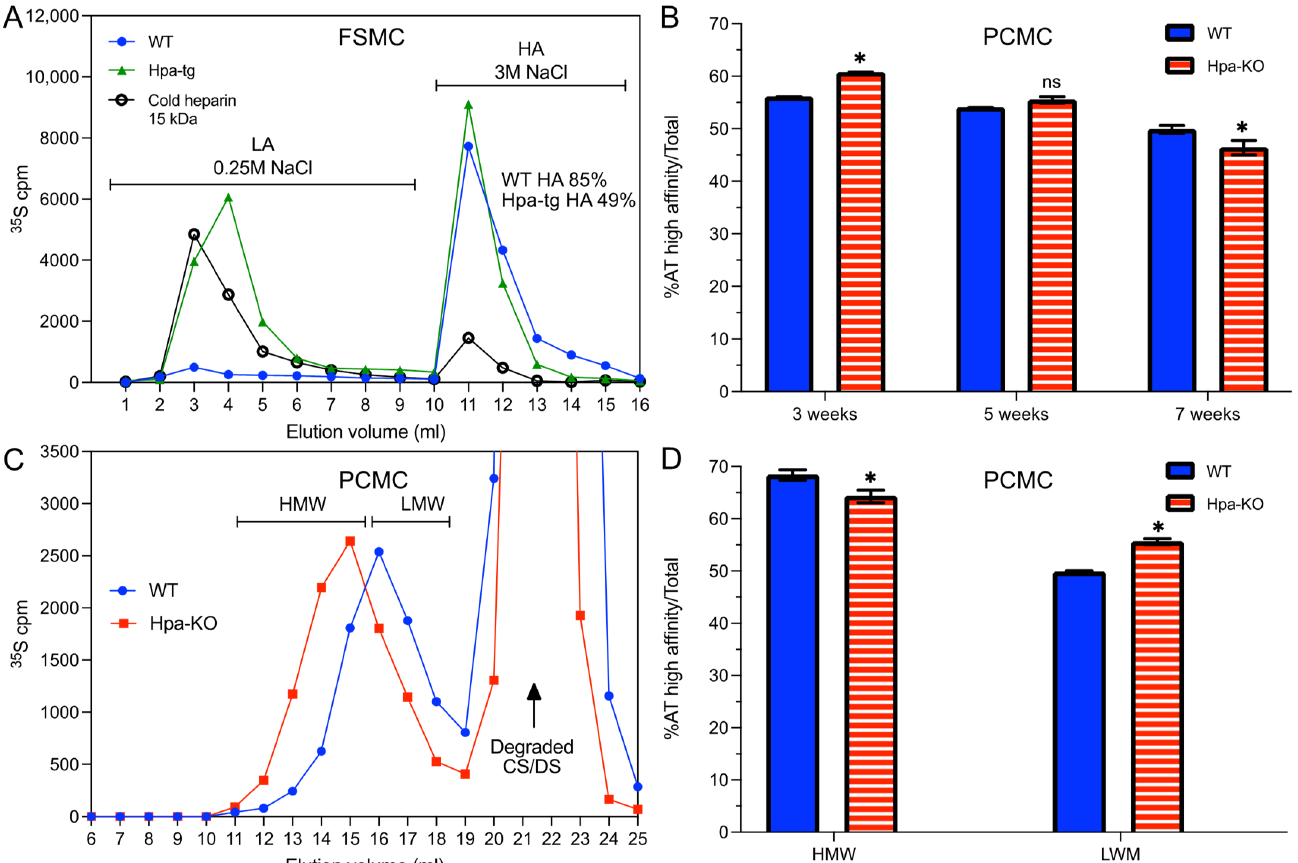
Figure 2. Chain-length and antithrombin binding capacity. ( A ) Metabolically 35 S-labeled FSMC heparin was applied onto antithrombin (AT)-Sepharose column and eluted with increasing NaCl concentrations. Blue circles : WT; green triangles : Hpa-Tg; black circles : commercial heparin. ( B ) Metabolically 35 S-labeled heparins isolated from PCMC cultivated for three, five, and seven weeks were fractionated on AT-Sepharose affinity column. Filled blue bars : WT; horizontally striped red bars : Hpa-KO. ( C ) Size fractionation of heparin isolated from PCMC cells cultivated for five weeks. The fractions of high molecular weight (HMW) and low molecular weight (LMW) heparin were pooled as indicated. Blue circles : WT; red squares : Hpa-KO. ( D ) The HMW and LMW heparin fractions prepared in ( C ) were fractionated on AT-Sepharose affinity column. Filled blue bars : WT ; horizontally striped red bars : Hpa-KO. Values in ( B , D ) represent the mean of analytical triplicates plus/minus one standard deviation. Two-tailed, unpaired t -test, * p < 0.05 Hpa-KO vs. WT within each cultivation time ( B ) or size pooling ( D ). The whole experiment was repeated two times with similar results.